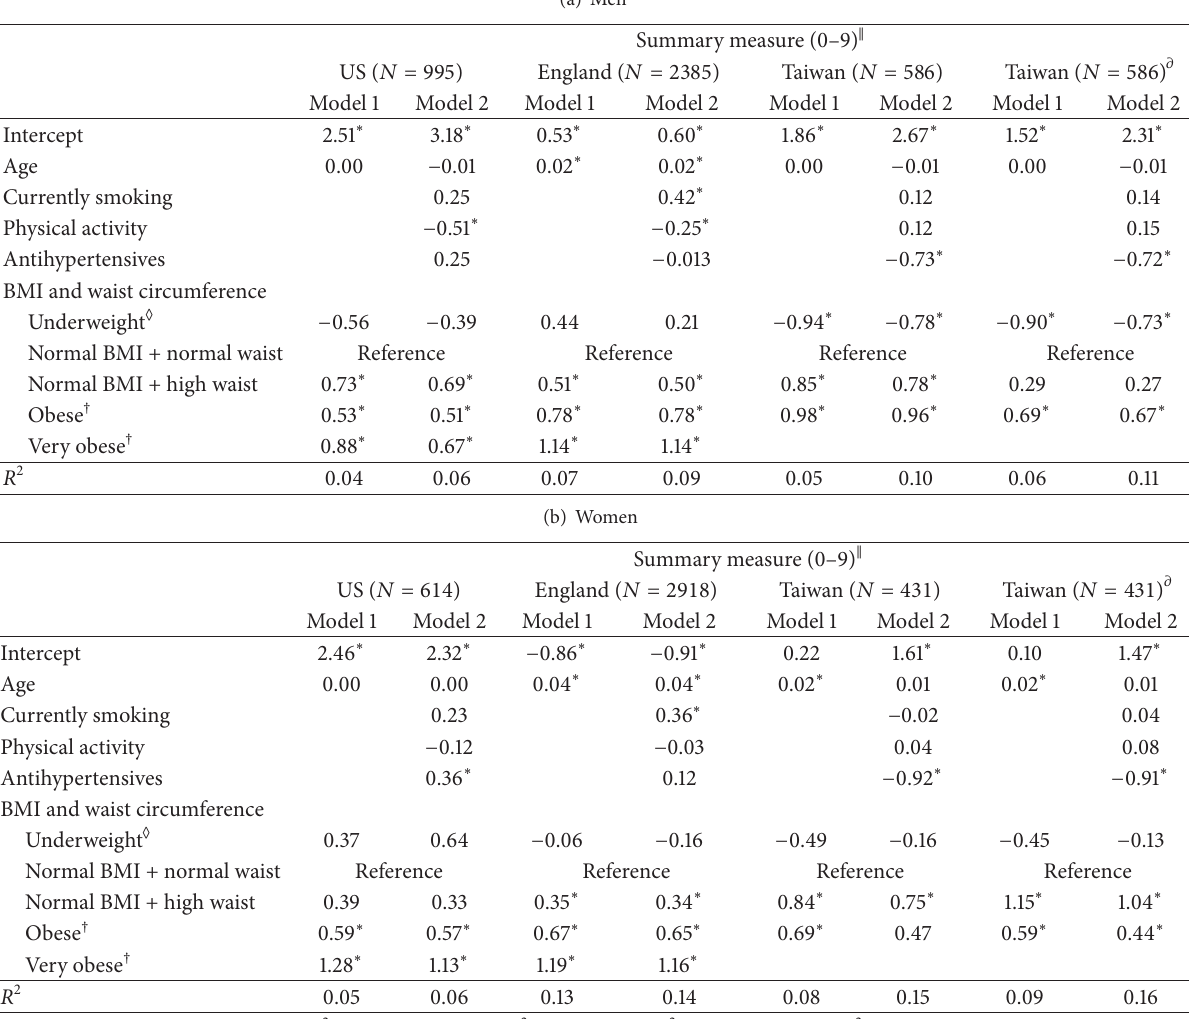
Table 4: Regression coefficients of the full summary measure (range: 0–9) ‖ of biological risk on body mass index (BMI) and waist circumference among older